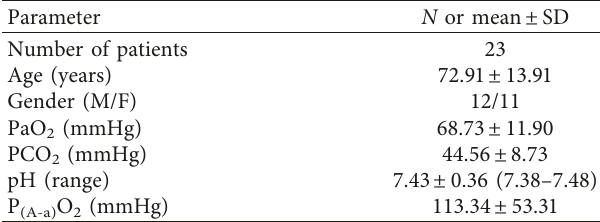
Table 1: Clinical characteristics of the patients studied.